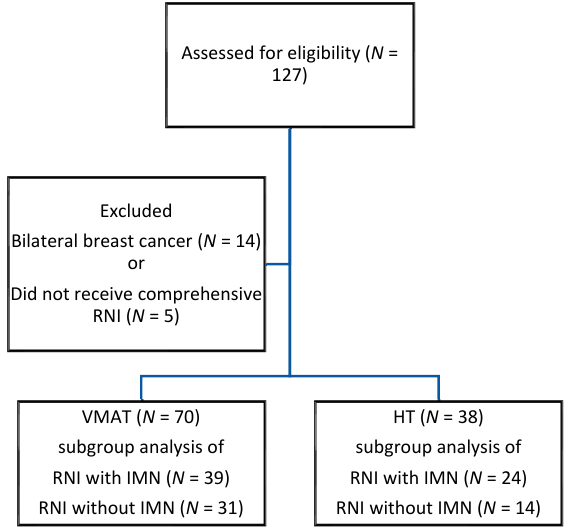
Figure 1. Patient Enrollment. Abbreviations: RNI—regional nodal irradiation; VMAT—volumetric-